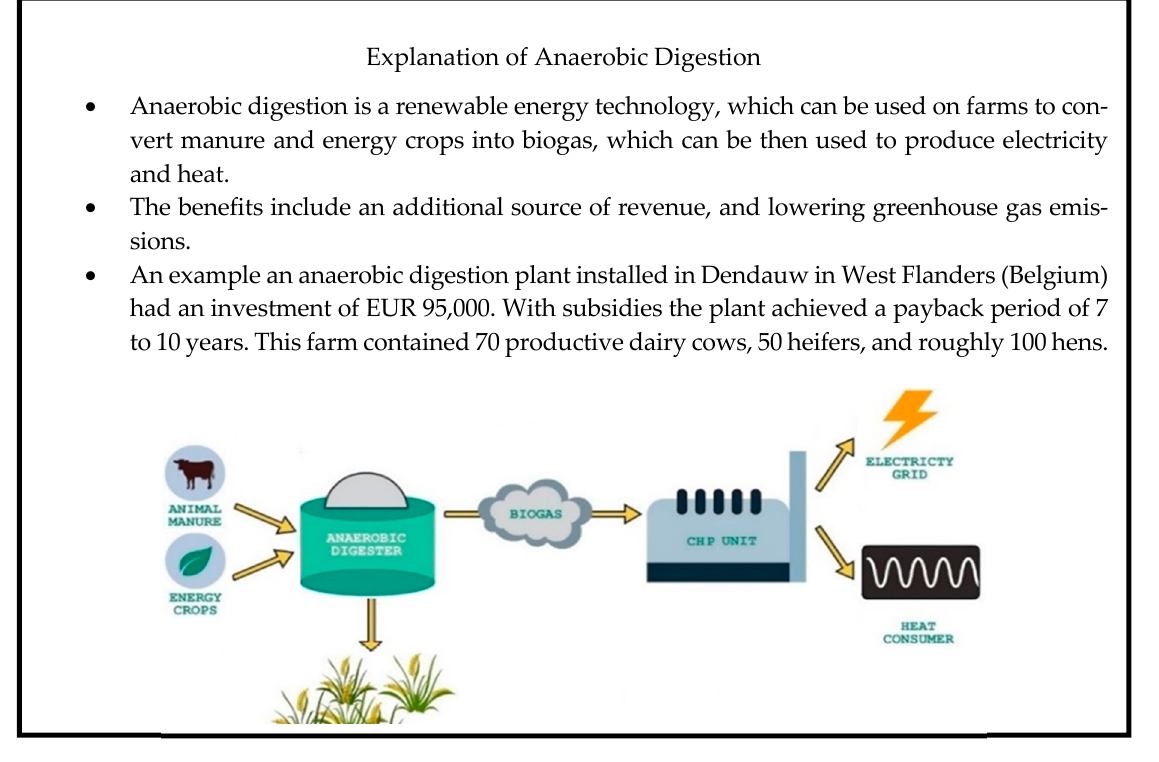
Figure 1. Explanation of AD included in the survey.